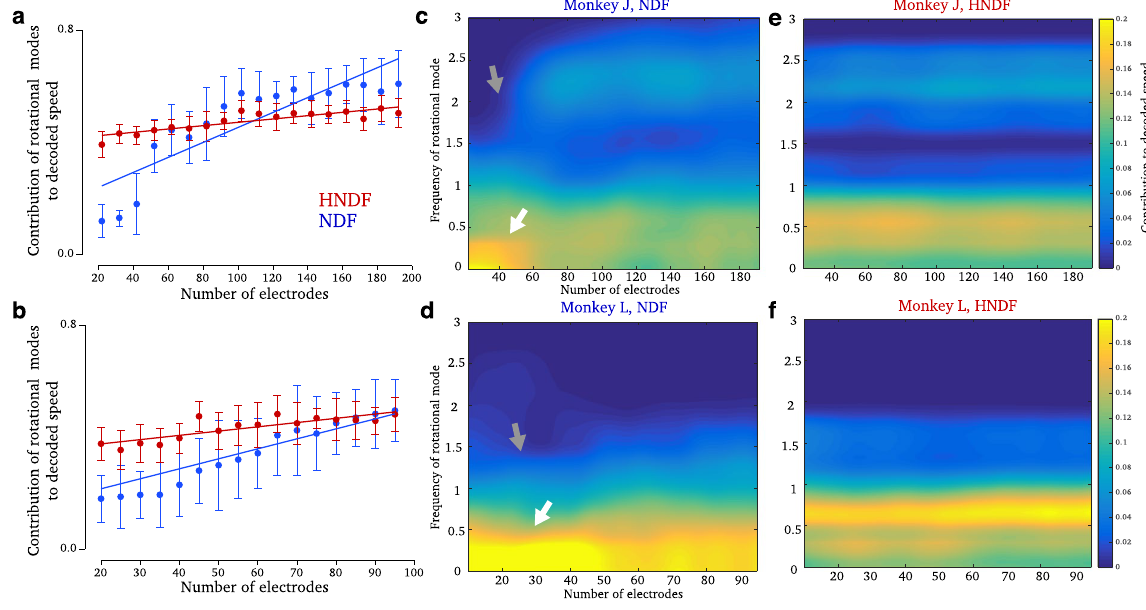
Figure 4. Contribution of rotational modes to decoding. ( a ) Contribution of rotational modes (versus purely exponentially decaying modes) to the decoded speed (Methods) in Monkey J. Error bars denote standard deviation. While both decoders demonstrate a decrease in contribution from rotational modes as electrodes are lost (slopes significantly different than 0, p < 0.01), the trend in the HNDF is substantially shallower than in the NDF (difference in slopes, p < 0.01). ( b ) Same as ( a ) but for Monkey L. ( c ) Contribution of rotational modes in Monkey J to the NDF, decomposed by frequency of the mode. Contribution from higher frequencies decreases as electrodes are lost (gray arrow) while contribution from lower frequencies and DC modes increases (white arrow). ( d ) Same as ( c ) but for Monkey L. ( e ) Same as ( c ) but for the HNDF decoder. The contributions from rotational modes is more consistent when dynamics are remembered, even as electrodes are lost. ( f ) Same as ( e ) but for Monkey